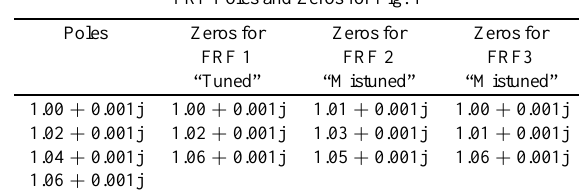
Fig. 1. The effect of different zero spacings on maximum response. Table 1 FRF Poles and Zeros for Fig.